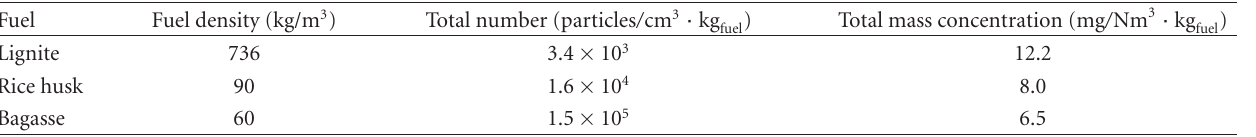
Table 2: Total number/mass concentration of